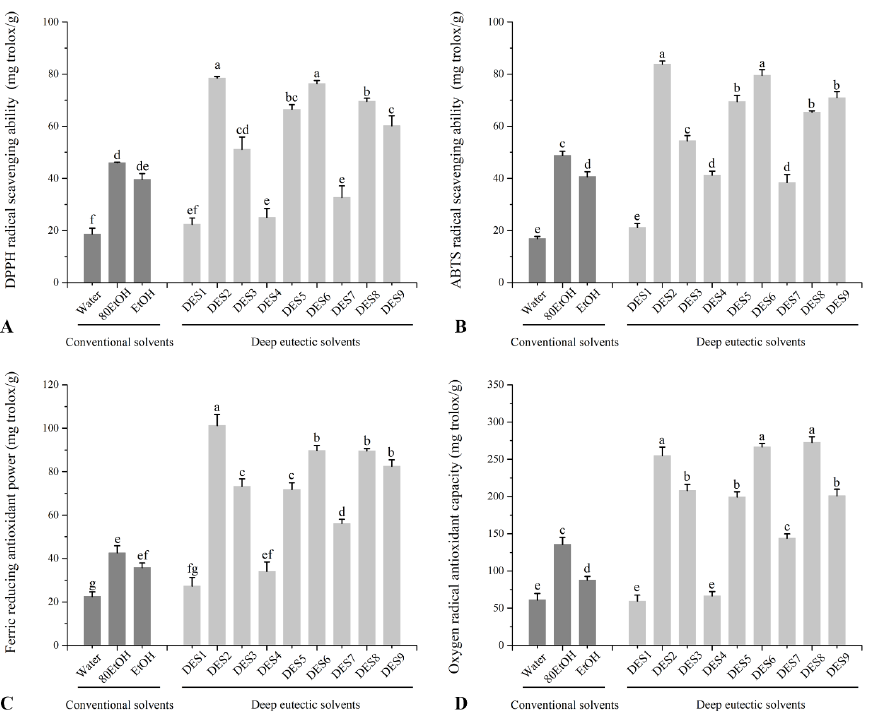
Figure 2. Effect of extraction solvent (conventional and deep eutectic solvents) on antioxidant capacity of ginger extract determined by ( A ) DPPH, ( B ) ABTS, ( C ) FRAP, and ( D ) ORAC assays. The corresponding solvents ’ abbreviations can be consulted in Table 1. Values are expressed as mean ± SD ( n = 3). Different letters in each series indicate significant differences ( p < 0.05); lowercase letters denote significant differences ( p < 0.05) between solvents.